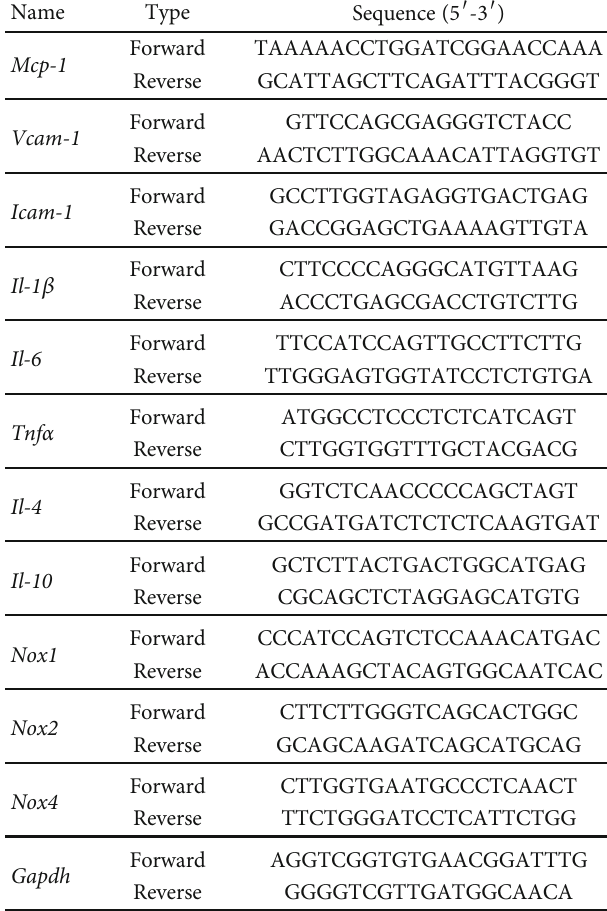
Table 1: Primer sequences used in the quantitative real-time PCR.